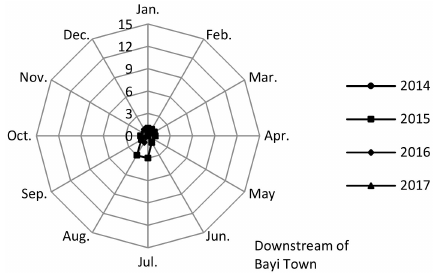
Figure 5. Tributaries.